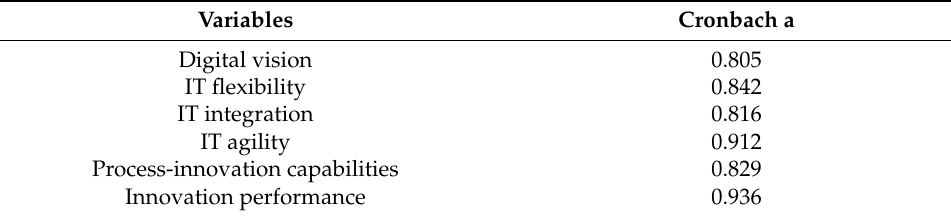
Table 2. Cronbach a.